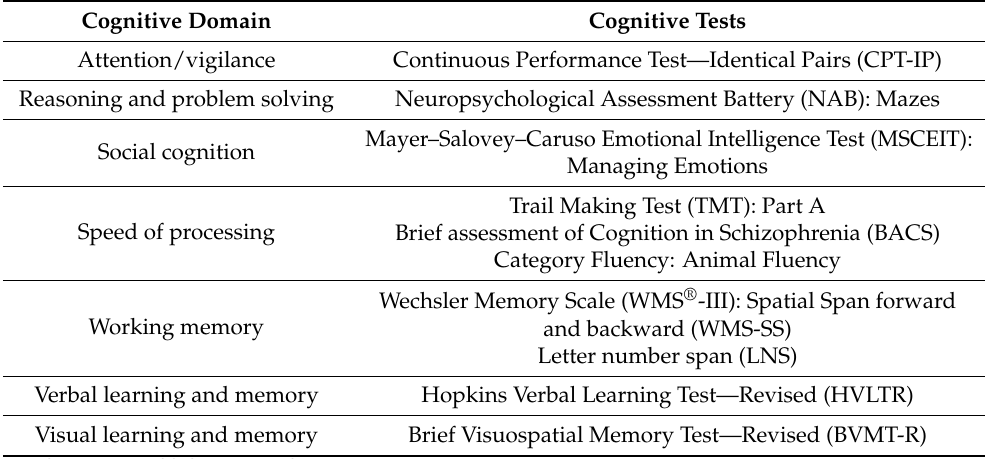
Table 1. Cognitive domains and cognitive tests from the MCCB